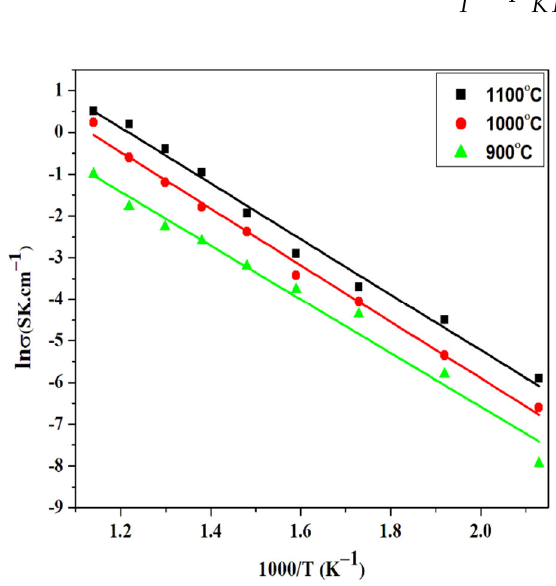
Figure 4. Conductivity curves of sintered BaCe 0.2 Zr 0.6 Y 0.2 O 3 − δ electrolyte .